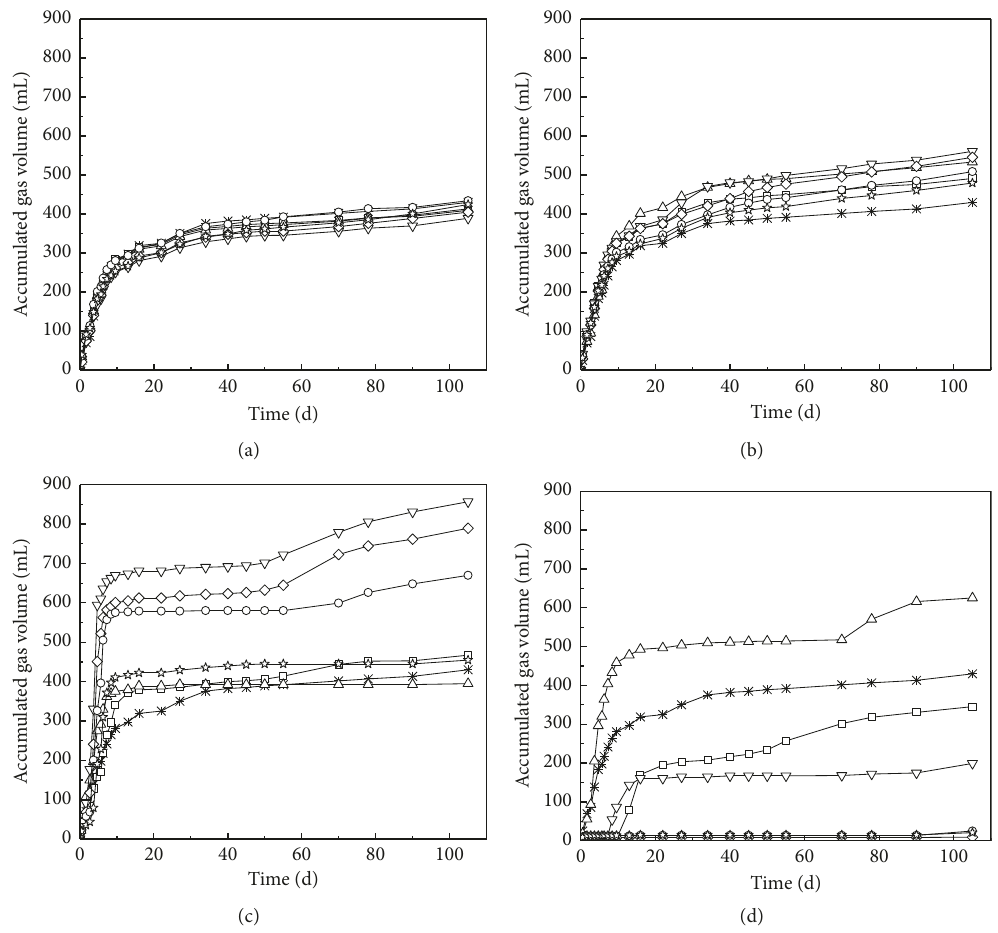
Figure 1: Effect of iron source on gas production. ( ∗ , Control; □ , 4000mg · kg − 1 ; △ , 8000mg · kg − 1 ; ▽ , 16000mg · kg − 1 ; ◇ , 24000mg · kg − 1 ; ○ , 32000mg · kg − 1 ; ☆ , 40000mg · kg − 1 ). (a) Fe 0 . (b) Fe 2 O 3 . (c) FeC 6 H 5 O 7 . (d) Fe 2 (SO 4 ) 3